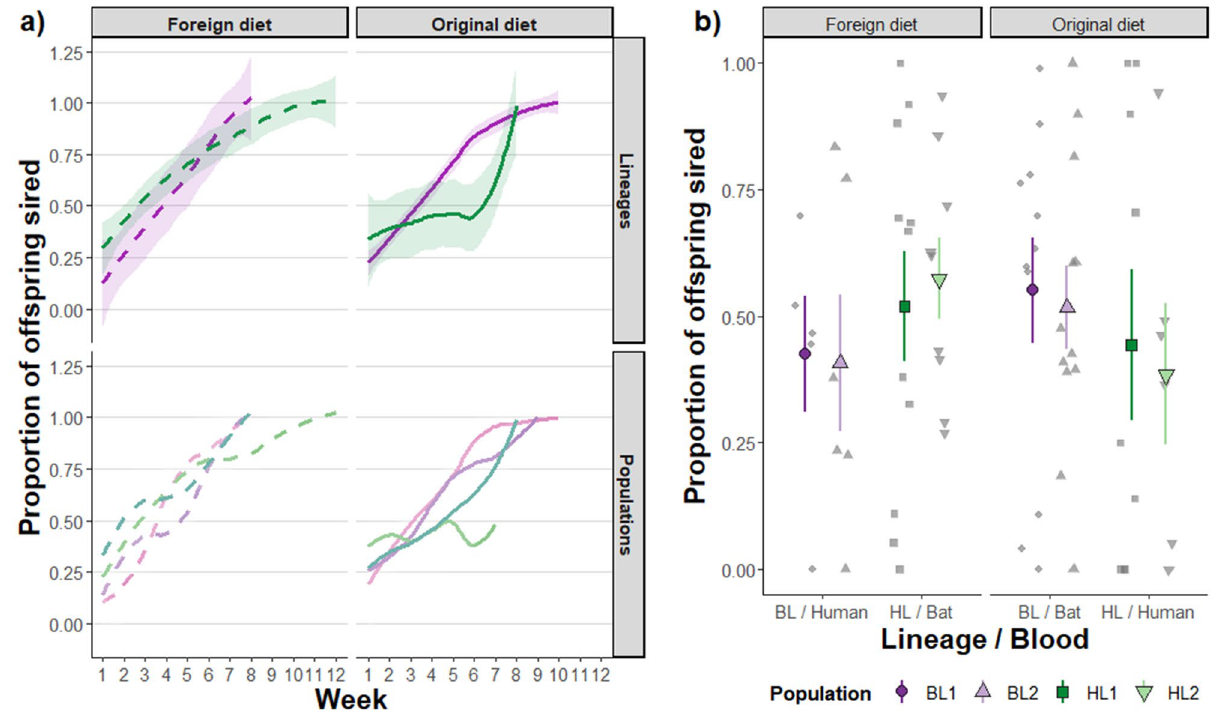
Figure 2. Effect of male diet on sperm competitive ability in the two different bedbug lineages. The proportion of sired offspring (paternity; P2) when tester females were mated first with males from the same population and subsequently with focal males differing in diet (original or foreign, resp. bat or human blood) and genetic origin (bat (BL, purple colour) or human lineage (HL, green colour)). ( a ) The change of P2 over the egg laying period varied between lineages and diets: P2 in HLs increased at a slower rate on human than on bat blood. Lightly coloured lines represent the average P2 over egg laying for each population and the dark coloured lines with 95% confidence intervals show the average P2 for the lineages. Solid lines correspond to the original diet, dashed lines to foreign diet. ( b ) The male’s origin or diet showed no clear effect on the overall P2, even though P2 seems to be generally higher on bat blood. Grey symbols represent individual data points. Coloured symbols and error bars show the mean and standard error for the individual male population (different colour shades and point